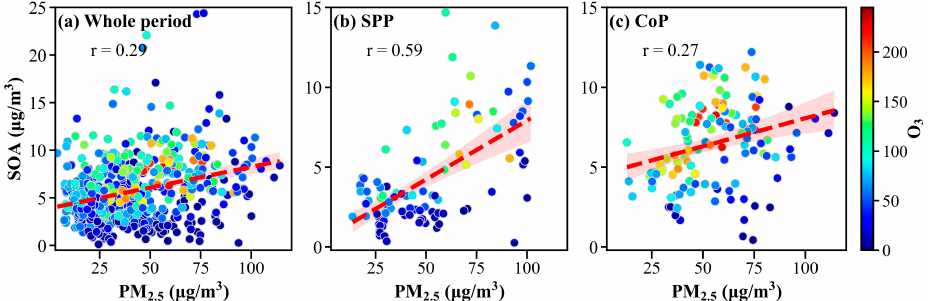
Figure 4. Scatter plots of the SOA and PM 2.5 concentrations during different pollution episodes. ( a ) for the whole period, ( b ) for the SPP episode, and ( c ) for the CoP episode. The red dashed line in each subplot is the linear regression line of the scatter plot.